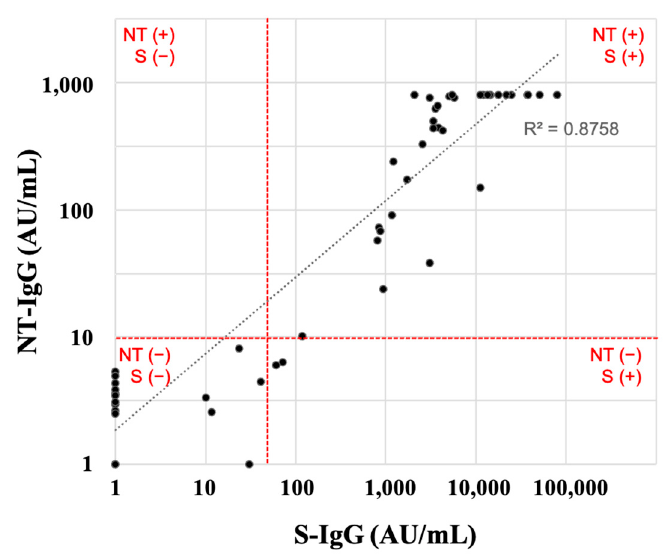
Figure 4. Correlation between NT-IgG and S-IgG after the third vaccination. The red line shows the cutoff value of NT-IgG and S-IgG, respectively. The dotted line shows the regression line. R, correlation coefficient; NT-IgG, neutralizing antibodies.